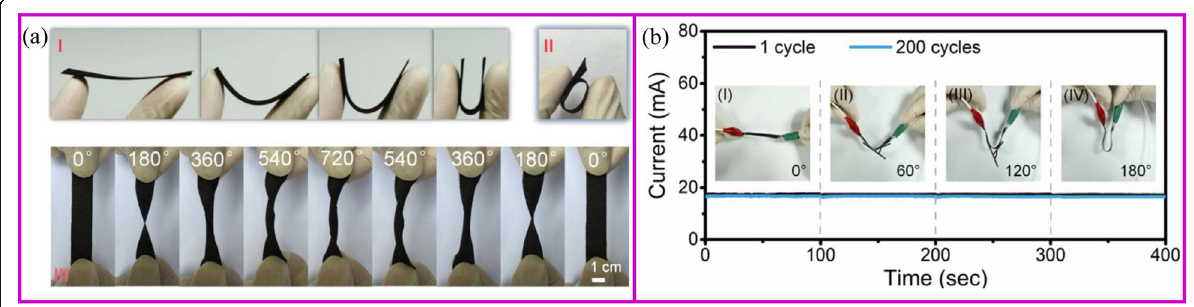
Fig. 11 a Schematic illustration for the structural features of the flexible SnO 2 nanosheets on flexible carbon cloth electrode during the folding (I), the rolling (II), and twisting (III) tests. b Current-time curves of the composite samples at various bending angles of the 1st and 200th cycles, and the inset images show the corresponding bending angles for measurement and photographs